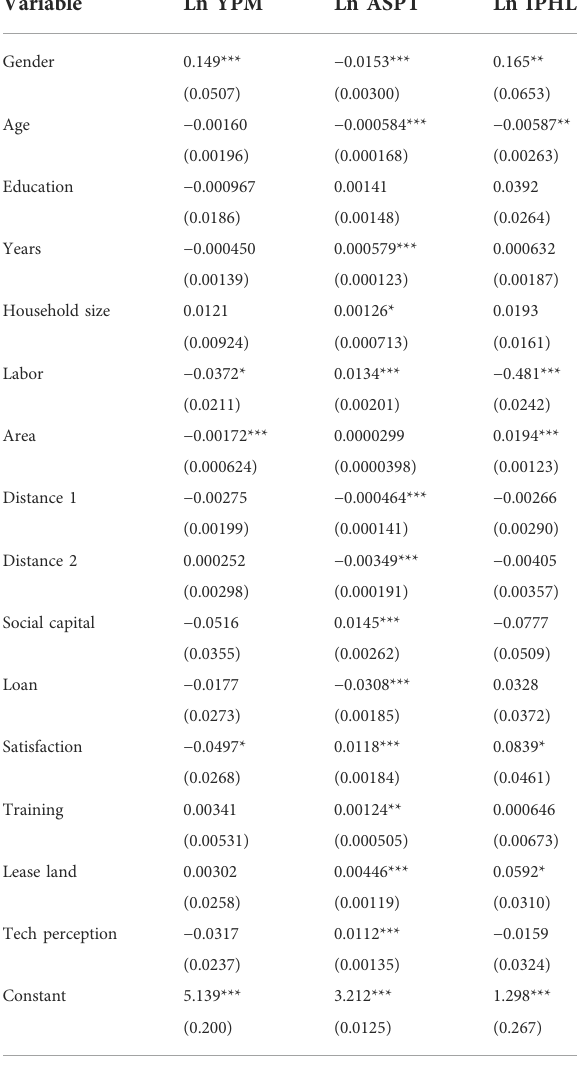
TABLE 6 Second stage estimates for YPM, ASPT, and